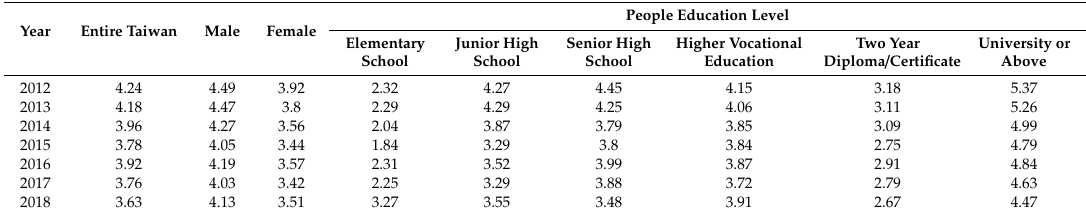
Table 1. Unemployment Rate in